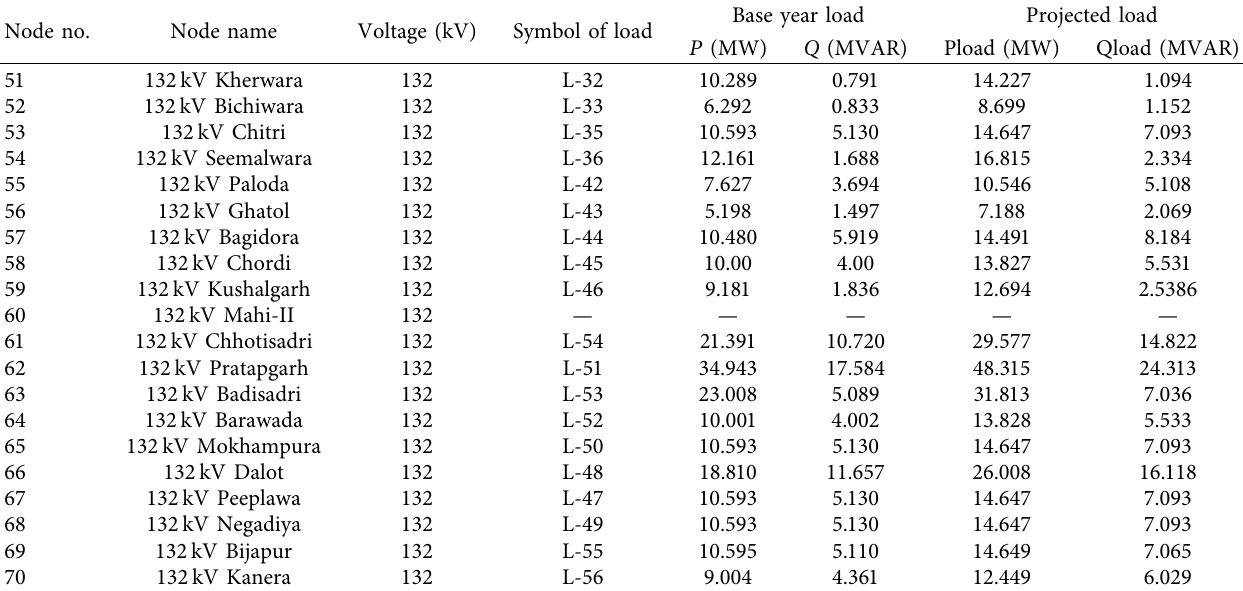
Table 2: Details of test system buses and loads (part-B)